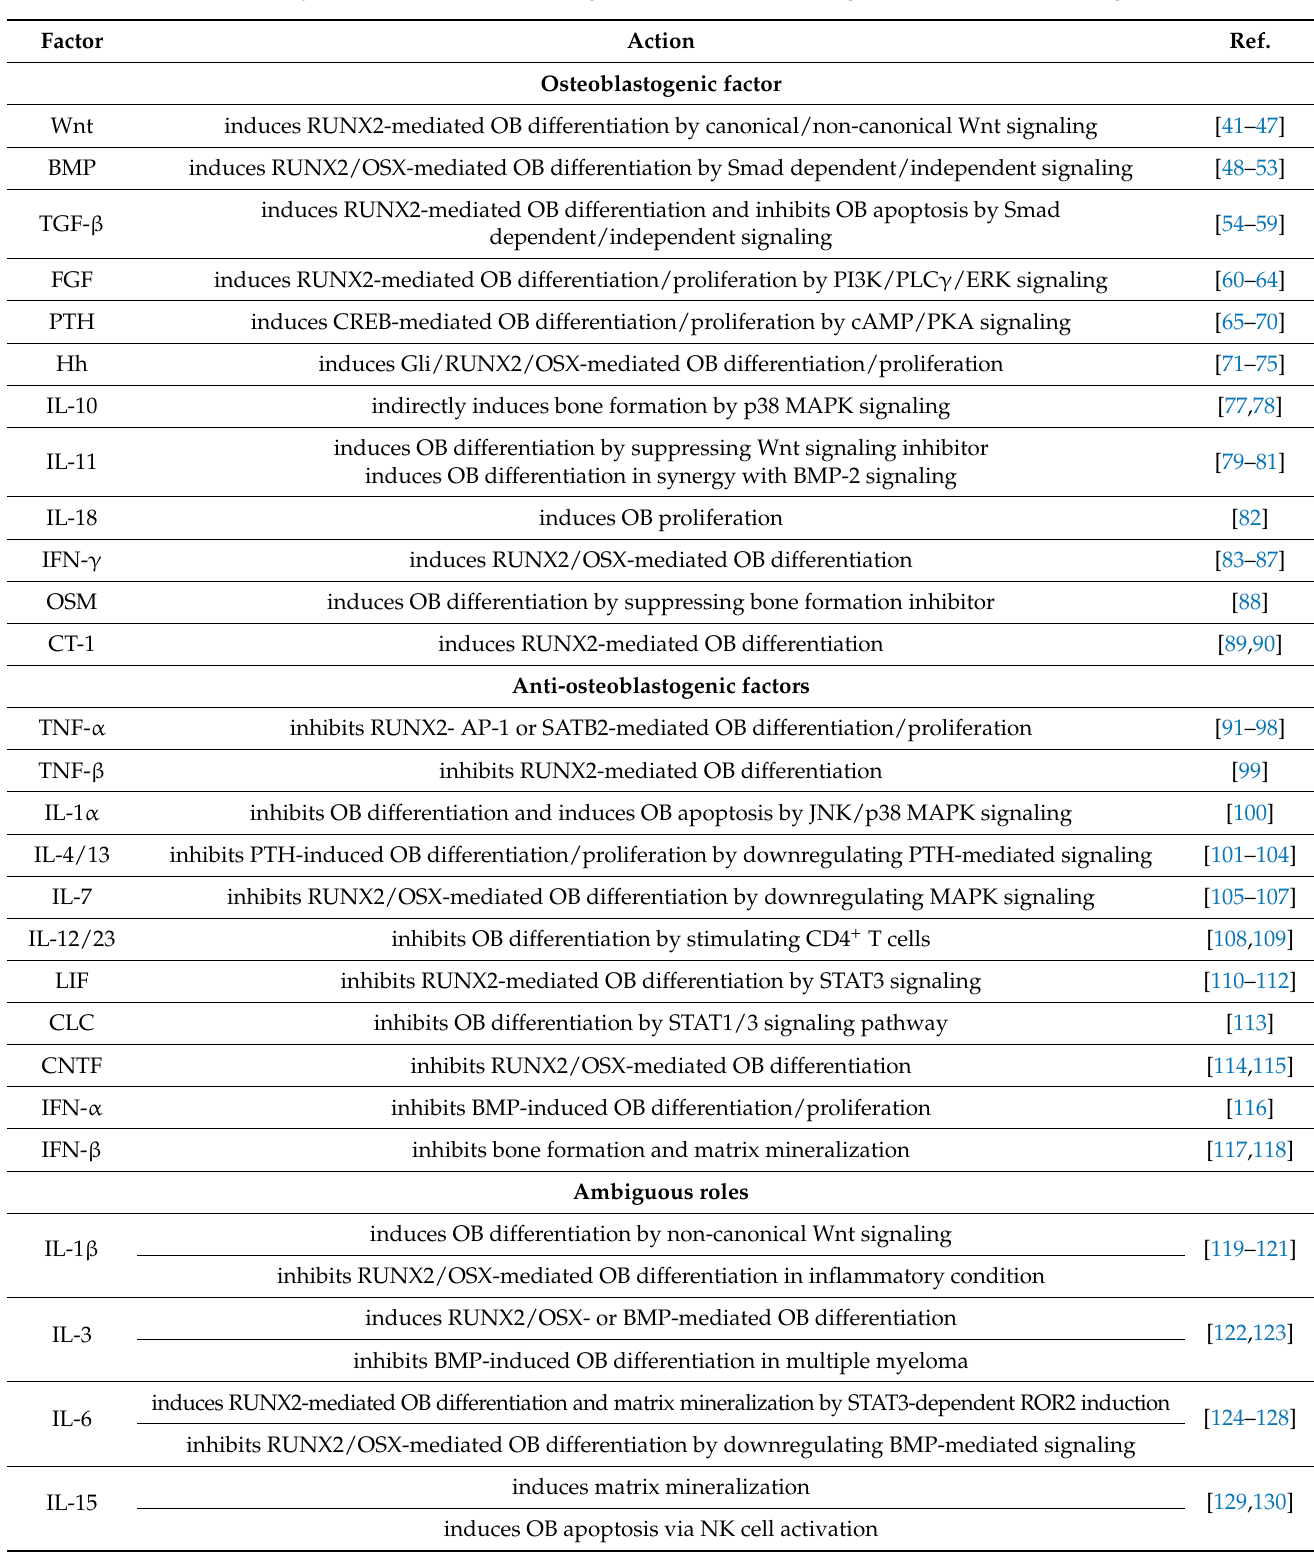
Table 1. Summary of the effects of osteoblastogenic and anti-osteoblastogenic factors in osteoblastogenesis. Factor Action Ref. Osteoblastogenic